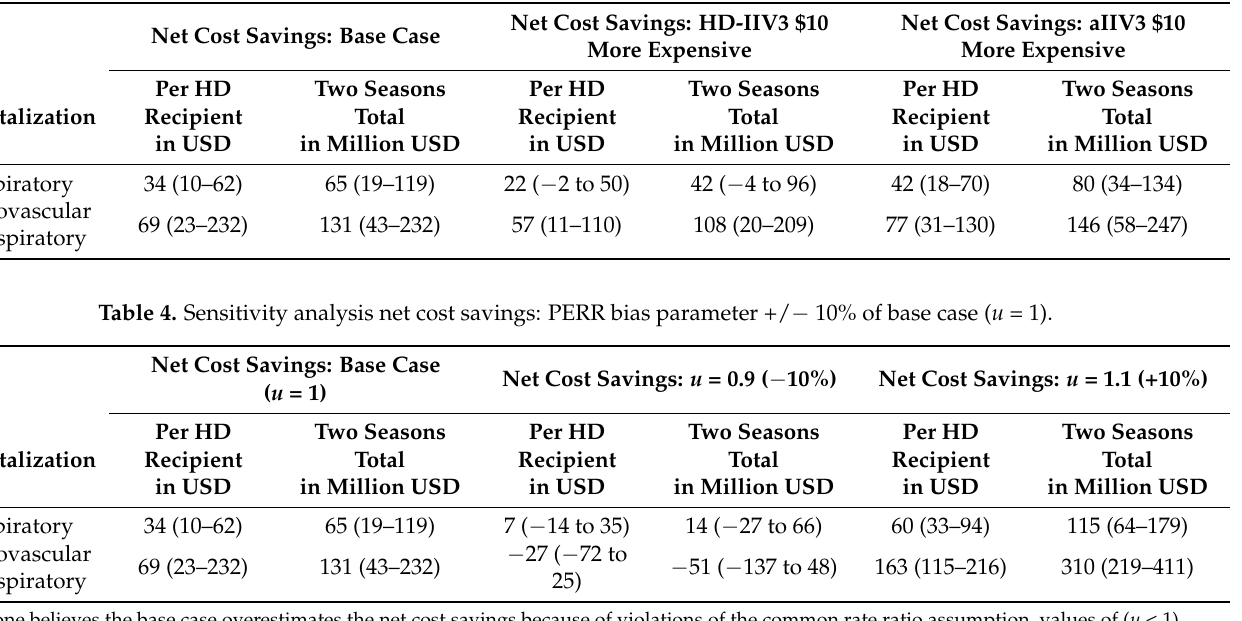
Table 3. Sensitivity analysis of the effect of a 10 USD vaccination price difference on the net cost savings.